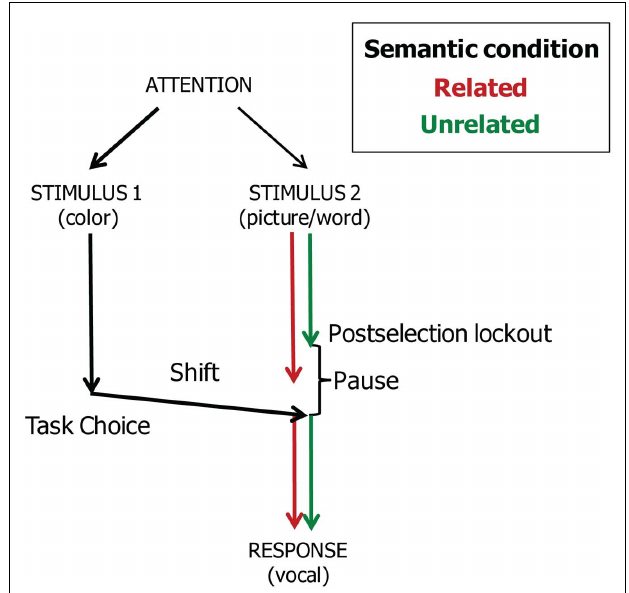
FIGURE 7 |Theoretical account of the timing of task-choice processes (Task 1) and vocal responding (Task 2) in the task-choice study of Piai et al. (2011). Pictures are named in semantically related and unrelated conditions.